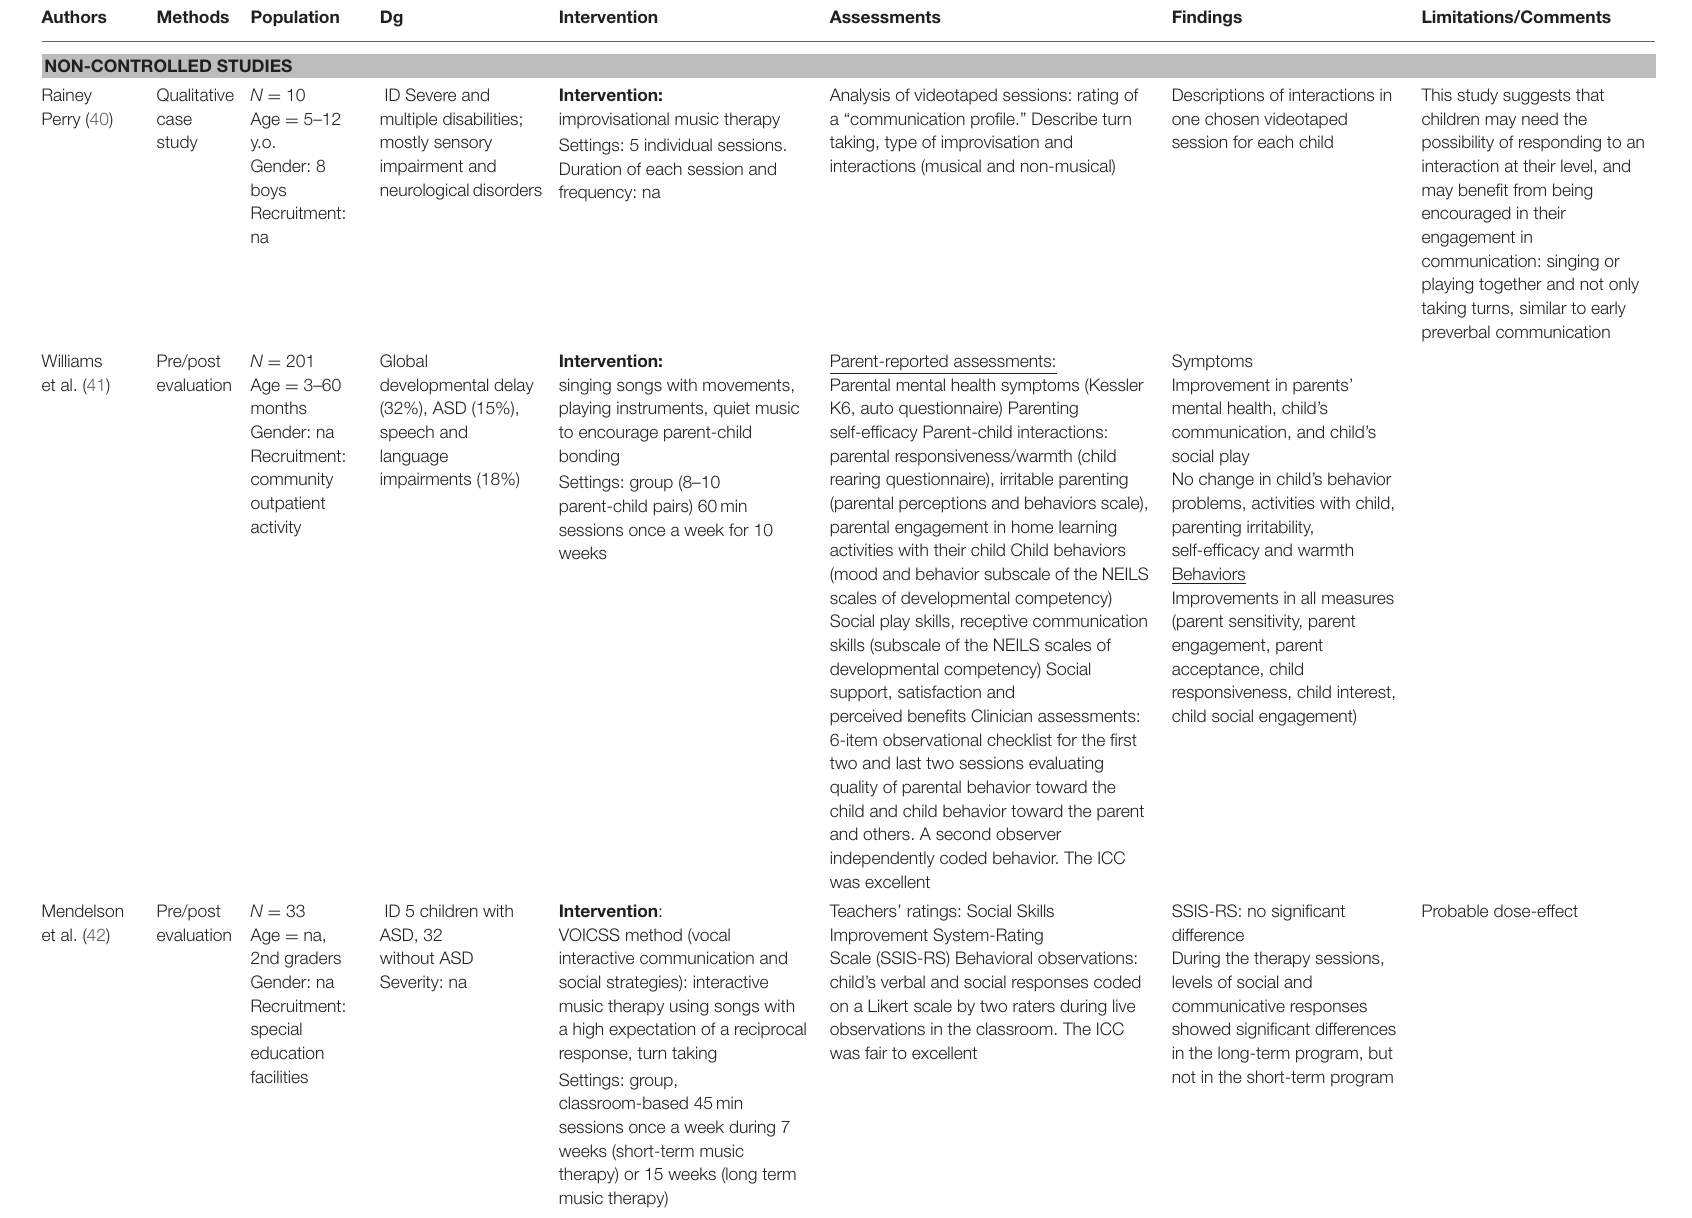
TABLE 3 | Studies assessing musicotherapy in youths with intellectual disability